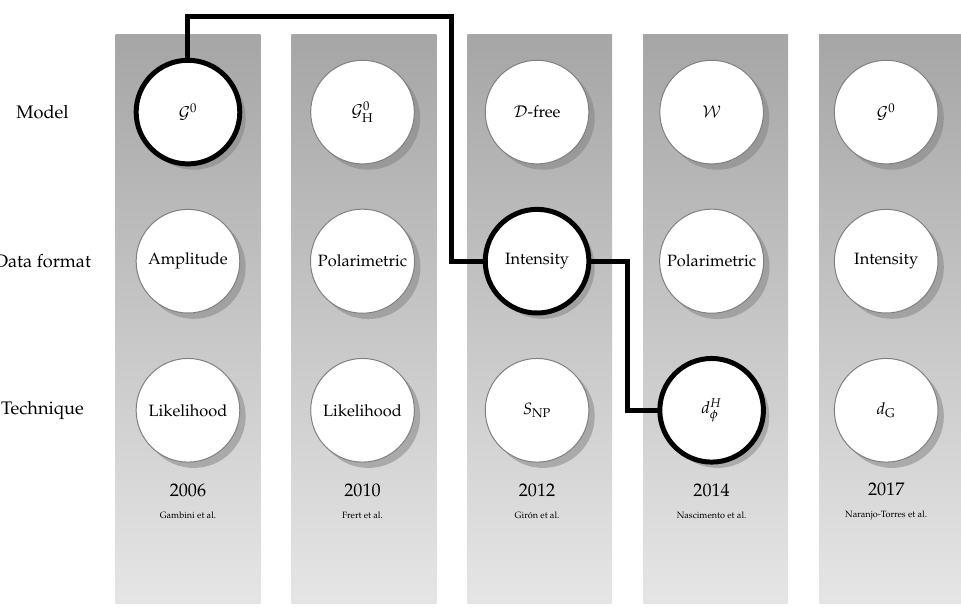
Figure 1. Chronological overview of the main edge detection approaches in SAR imagery using the Gambini Algorithm [22,24–27]. The contribution of this work is shown in bold